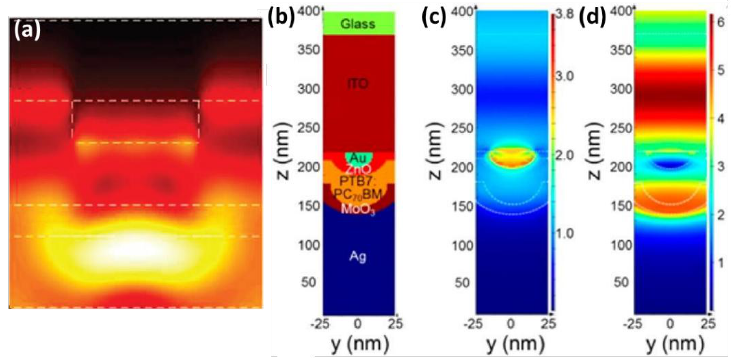
Figure 2. ( a ) Waveguide model at the wavelength of 400 nm [35]; ( b ) device material profile; and ( c ) electric and ( d ) magnetic field intensity profiles on Au NPs at 560 nm [37]. Reprinted with permission from Ref. [35] and Ref. [37].